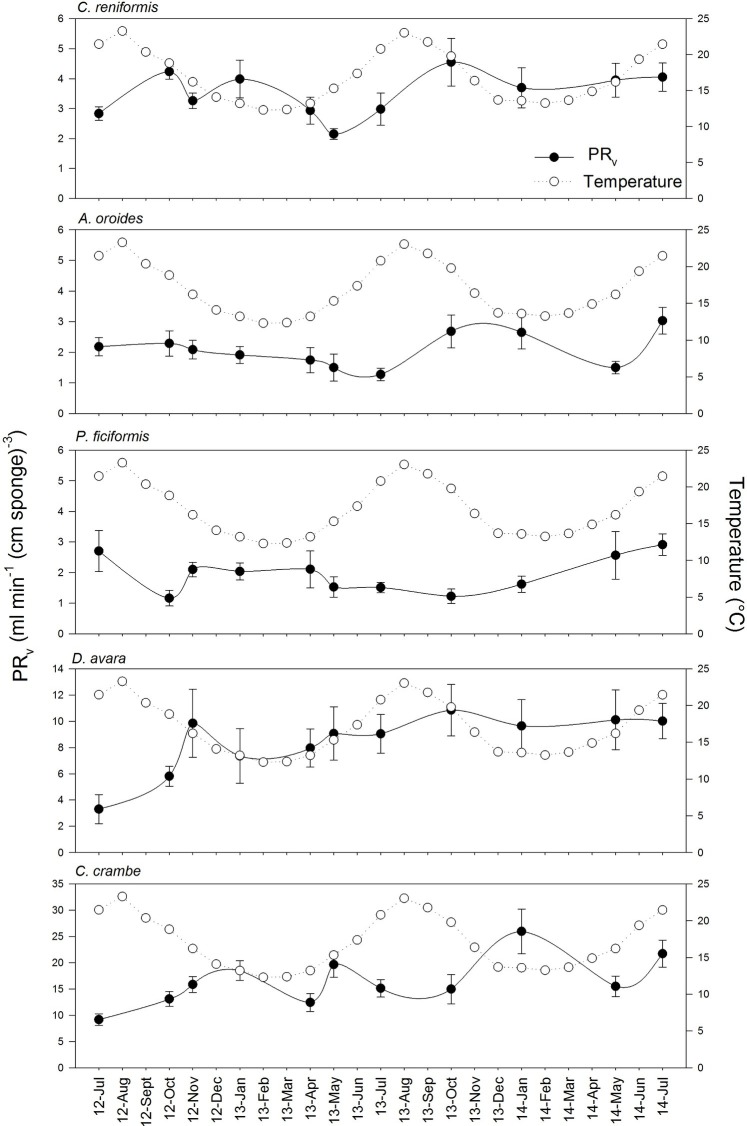
Variation of volume-specific pumping rates [PRV, ml min−1 (cm sponge)−3] throughout the years in the five study species. The temperature variation over the annual cycles at the study site is included in each species graph as empty dots. Data are expressed as mean ± SE. The maximal seasonal variation of PRV was 2.5 folds, depending on the species: A. oroides, 2.4; C. reniformis, 2.1; P. ficiformis, 2.5; D. avara, 1.9; C. crambe, 2.1.